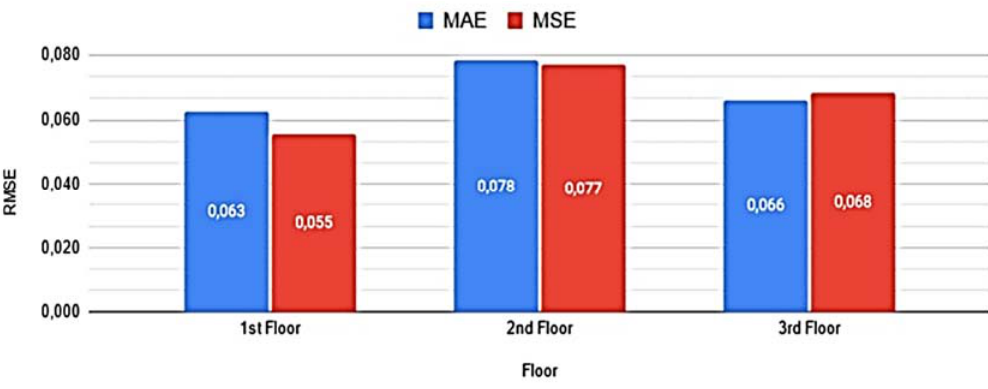
Figure 27. Average RMSE concerning loss function by floor for the validation set on 2 h prediction horizon.